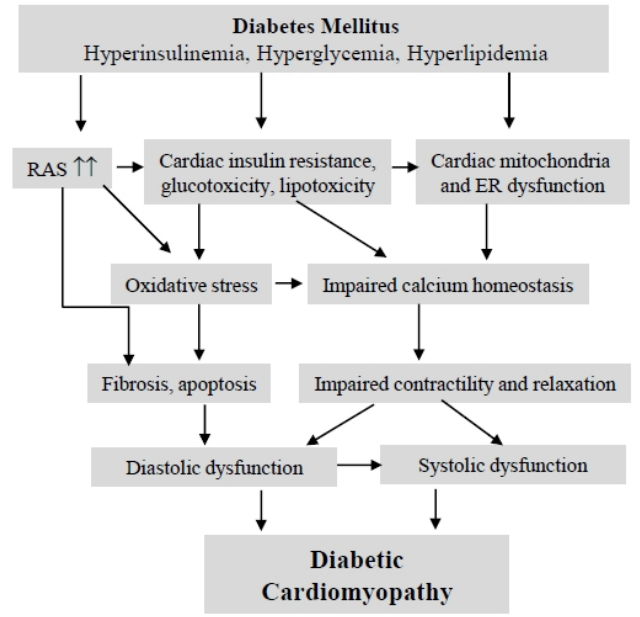
Figure 1. The pathophysiology of diabetic cardiomyopathy. Diabetes-induced cardiac insulin resistance, glucose/lipid dysmetabolism and activation of the renin-angiotensin system promote the development and progression of diabetic cardiomyopathy (DCM). ER, endoplasmic reticulum; RAS, renin-angiotensin